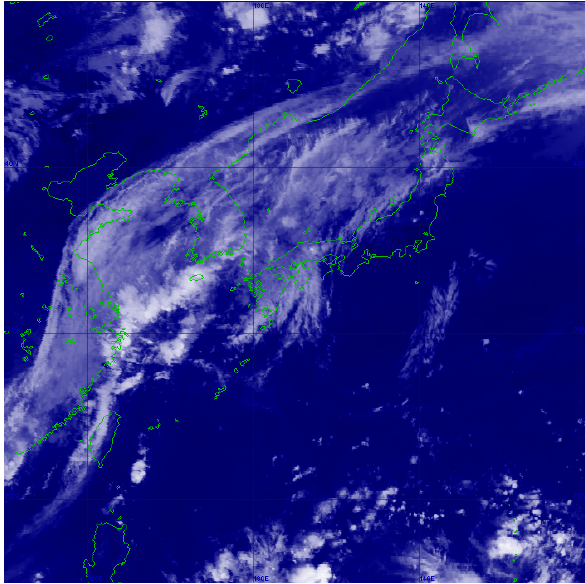
Figure 3. JMA weather satellite image (3:40 August 20, 2014).